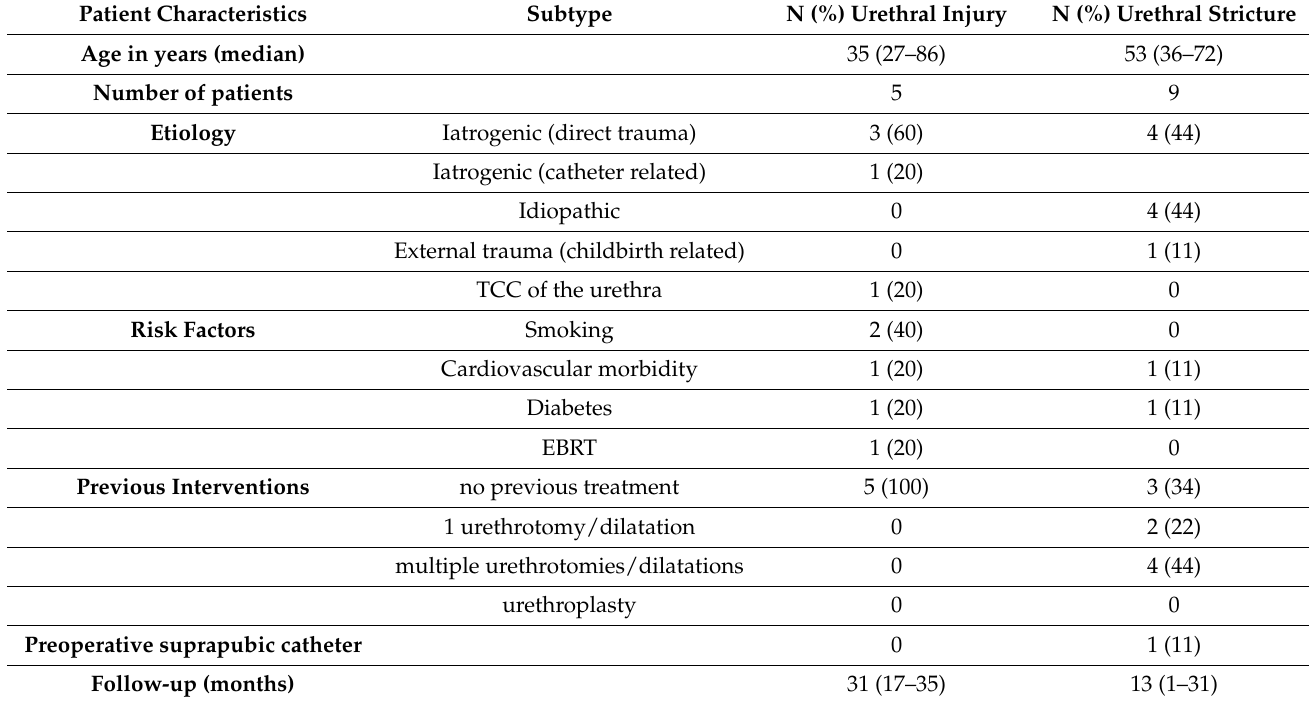
Table 1. Patient Characteristics.